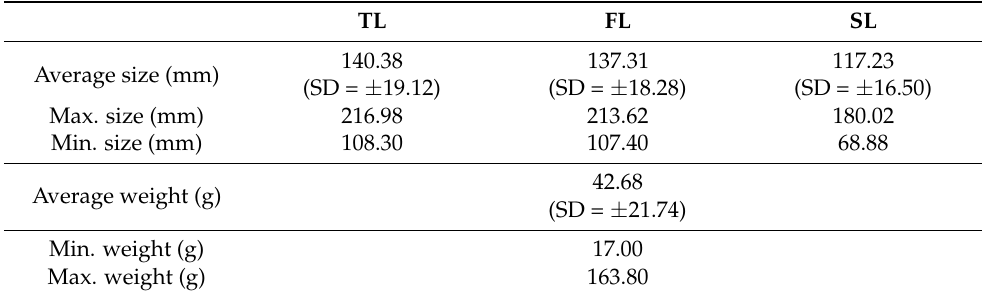
Table 4. Average minimal and maximal sizes (TL = total length, FL = fork length, SL = standard length) and weight of 150 specimens of S. scriba